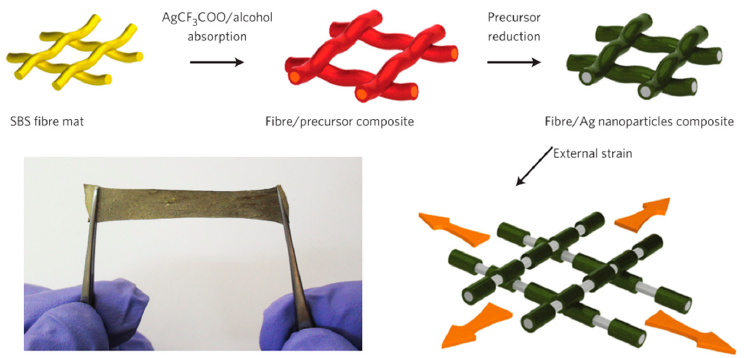
Figure 1. The schematic of fabrication process and the photograph of an SBS (styrene-block- butadiene-block-styrene) fiber mat-based stretchable conductor. Reprinted by permission from Macmillan Publishers Ltd.: Nat. Nanotechnol. [79], Copyright 2012. Table 1. Elastomers for stretchable conductors and their elastic properties.